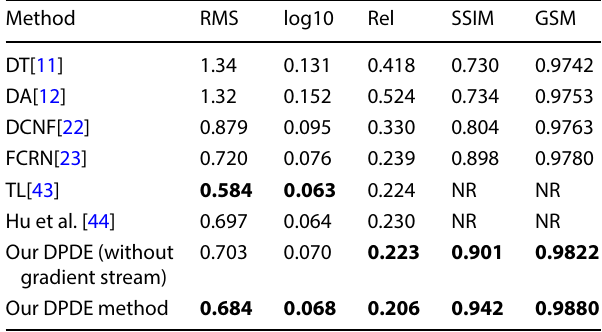
Table 3 Comparison results on MID dataset